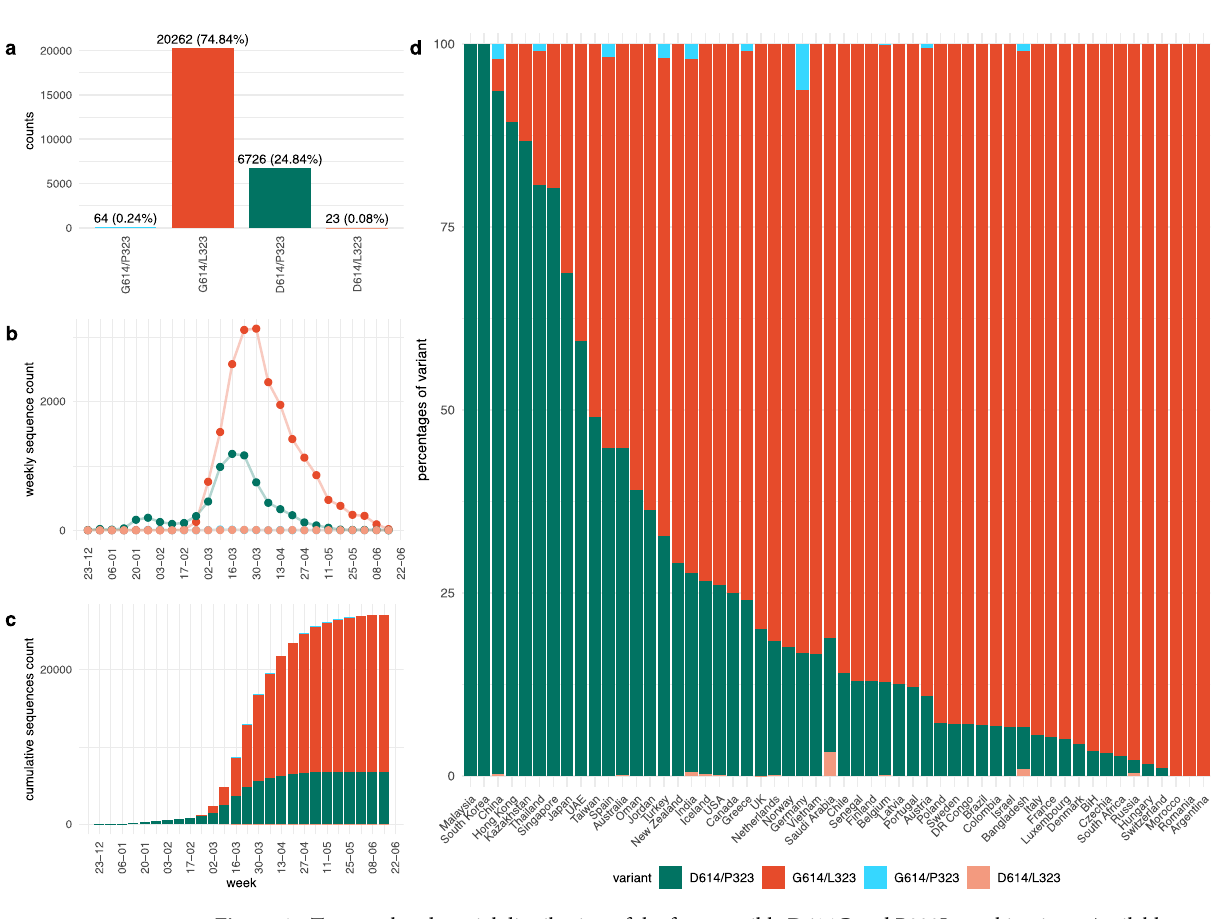
a second wave with a predominance of the G614/L323 variant can be observed. We also observed major differ- ences between the variants in different countries (Fig. 4d). For example, while D614/P323 was the largely domi- nant variant in Hong Kong, South Korea and China; G614/L323 was almost exclusively observed in countries such as Switzerland, Czechia and Argentina. We also note that the occurrence of single mutants (G614/P323 and D614/L323) continued to be rare. To better understand the relationship between the dynamics and geographic aspects of the pandemic, we analysed the weekly and cumulative numbers of sequences (Fig. 5) in different countries (only countries with at least 20 sequences were included in this analysis). At first glance, the D614/P323 variant can be observed as the dominant strain in the initial wave in Asian countries, while the G614/L323 variant was the main driver of the pandemic in other continents. However, in several Asian countries, including Taiwan, Thailand, Japan; the emergence of G614/L323 can be observed at later time points. Also, in many non-Asian countries, the pandemic started with the D614/P323 variant, followed by a strong predominance of the G614/L323 variant (e.g. Italy, UK, USA). Thus, country-by-country data do not suggest a simple geographic predominance or a bottleneck in the transmission that led to a random emergence of G614/L323 in non-Asian countries. Rather, it appears that G614/L323 is epidemiologically more successful than the original D614/P323 variant. We also investigated the case fatality rate in different countries as a function of the percentage of D614/P323 vs. G614/L323. We found no significant correlation between strain predominance and either deaths per million population (Fig. 6a) or case fatality rate (Fig. 6b). However, we cannot entirely exclude such a correlation, as there was a weak trend towards a higher case fatality rate in countries with a high percentage of the G614/L323 variant. We next investigated the epidemiological parameters in more detail. In 66 countries, sequences of both the D614/P323 variant and the G614/L323 were reported. In 37 countries, the D614/P323 variant was reported before the G614/L323 (Fig. 7a, light blue bars); while in 24 countries, the double mutation was reported first (Fig. 7a, dark blue bars). In five countries, both variants were reported for the first time on the same date. Note that even in countries where the D614/P323 variant was reported more than 20 days before the G614/L323, ultimately a clear predominance of the G614/L323 variant was observed (e.g. Belgium, USA, France). We, therefore, decided